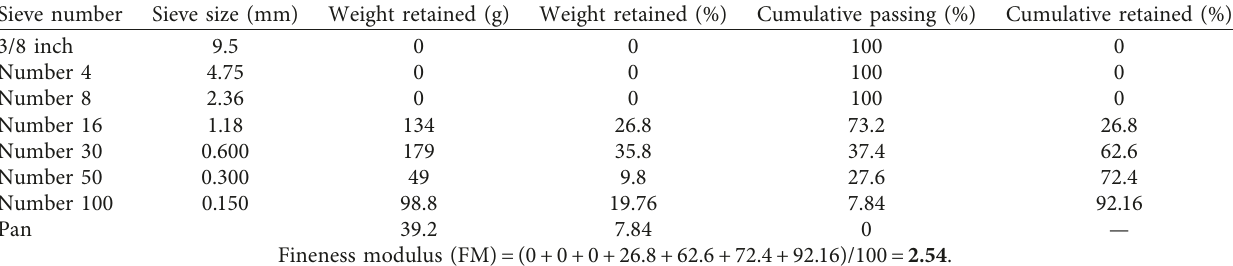
Table 1: Grain size distribution of fine aggregate (EN 196-1 and ISO 679:2009).